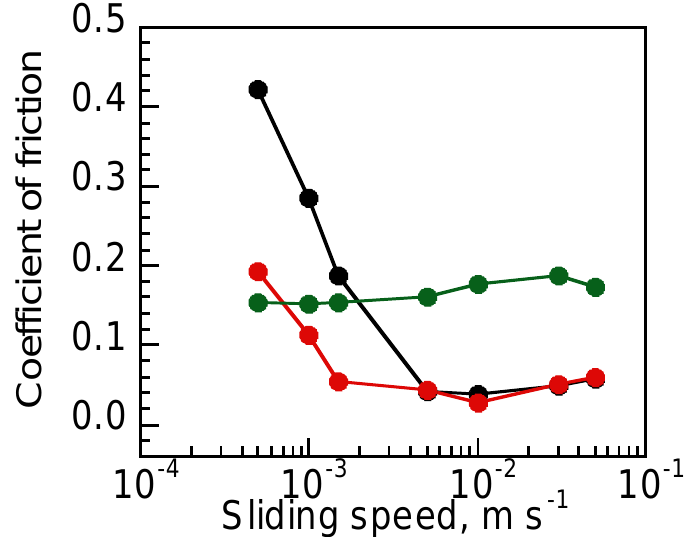
Figure 6. Sliding speed dependency of the COF measured at glass/DNIG-1 (black), SUS304/DNIG-1 (red) and PTFE/DNIG-1 (green).